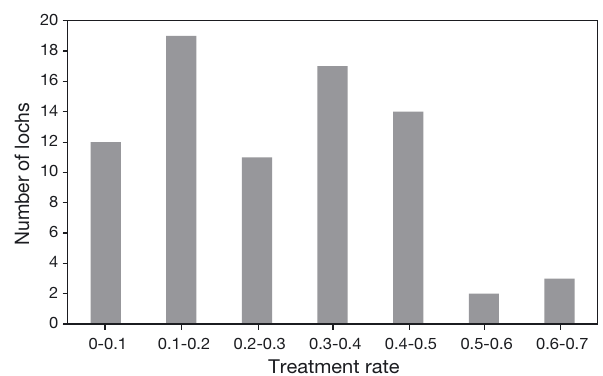
Fig. 3. Distribution of average rates of sea lice treatment between